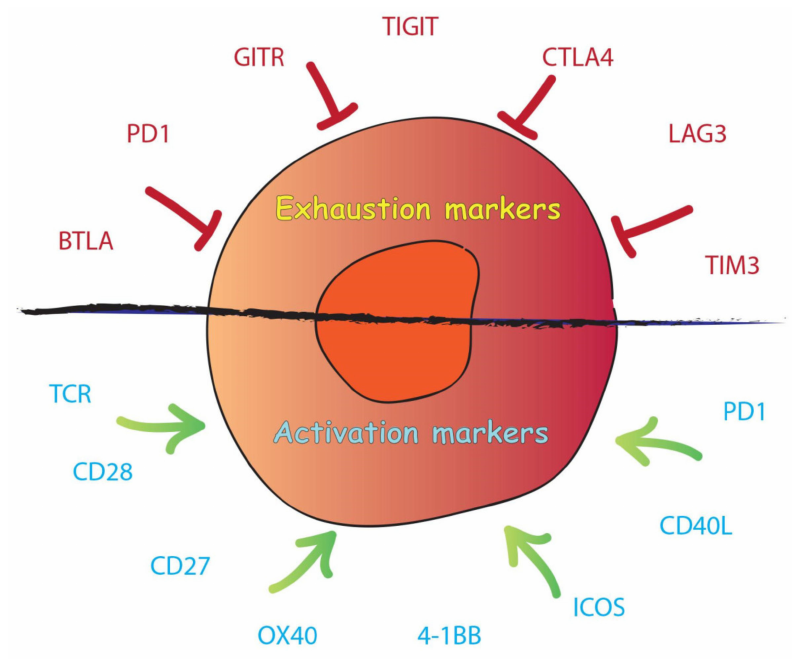
Figure 2. Scheme of T-cell exhaustion and T-cell activation